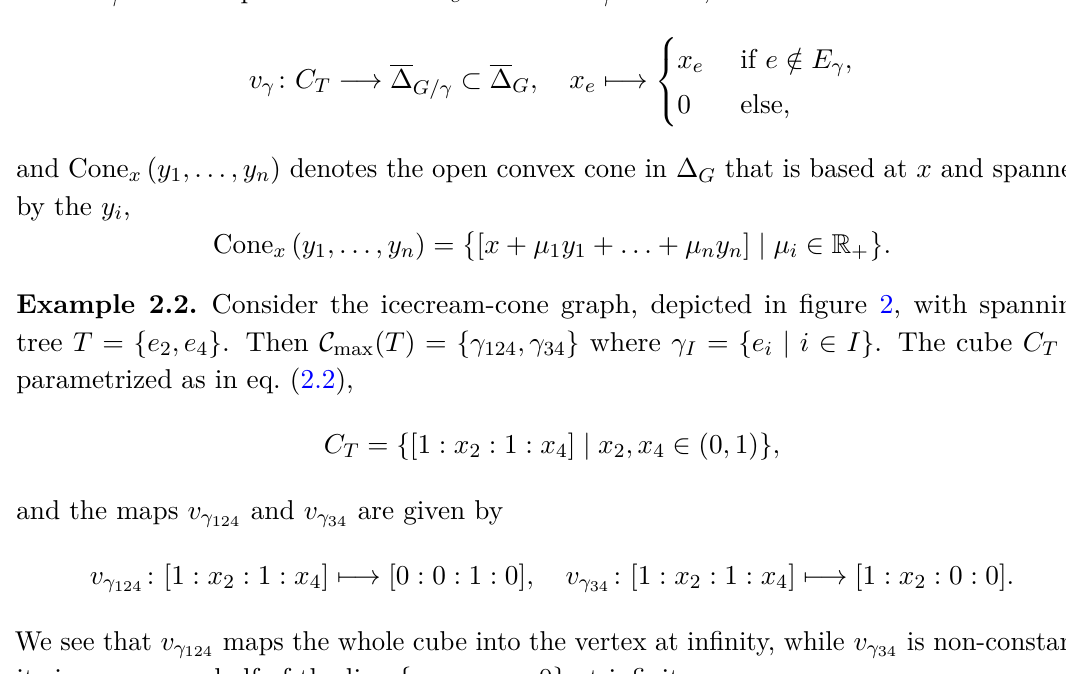
. Here C ( T ) consists of the two subgraphs with edge sets G max